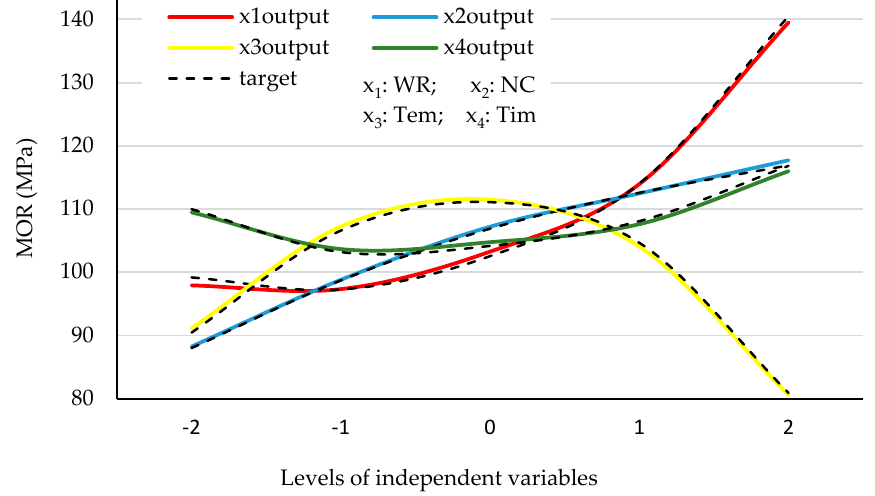
Figure 4. Direct effects of the independent variables on the MOR. x 1 : WR; x 2 : NC; x 3 : Tem; x 4 : Tim.